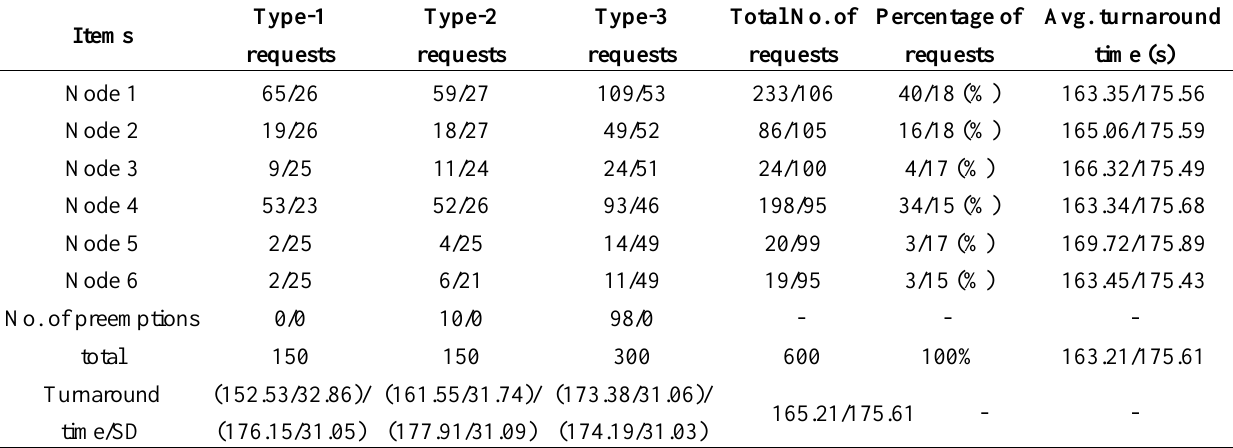
Table 16. The numbers of requests allocated and their turnaround times when 150 type-1, 150 type-2, and 300 type-3 requests were submitted, and the SPA-WP/Random were